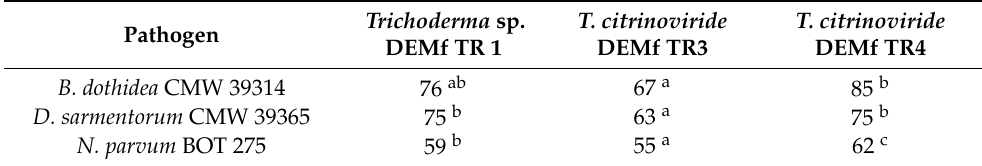
Table 2. Mycelial growth inhibition (%) of B. dothidea , D. sarmentorum and N. parvum by Trichoderma spp. isolated from P. sylvestris bark.